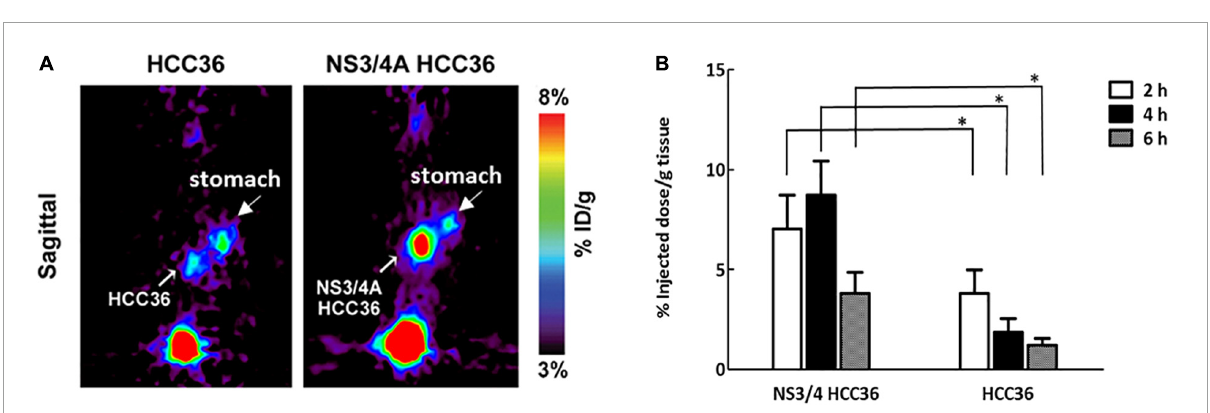
FIGURE7 Micro-PET Imaging of NS3/4A activity in orthotopic liver implantation model. The NS3/4A-HCC36 tumors or HCC36 tumors from the ectopic tumors were harvested and transplanted into the left liver lobe of SCID mice ( n = 3). After 2 weeks, the 3,700 kBq of TAT- (cid:49) NS3/4A- 124 I-FITC was intravenously injected. (A) PET imaging was performed at 4 h after injection of the probe. (B) The accumulation of radioactivity in NS3/4A-HCC36 tumors and HCC36 tumors was measured using a gamma-counter at 2 (white column), 4 (black column), and 6 (gray column) h after probe injection. Data represent mean ± SEM. Student’s t -test analysis of data. Statistical analysis was compared NS3/4A-HCC36 with HCC36. P < 0.05 was considered statistically